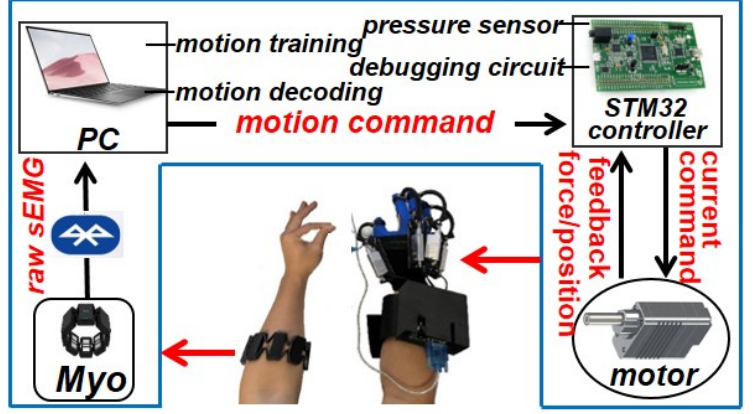
Figure 20. Block diagram of the system.